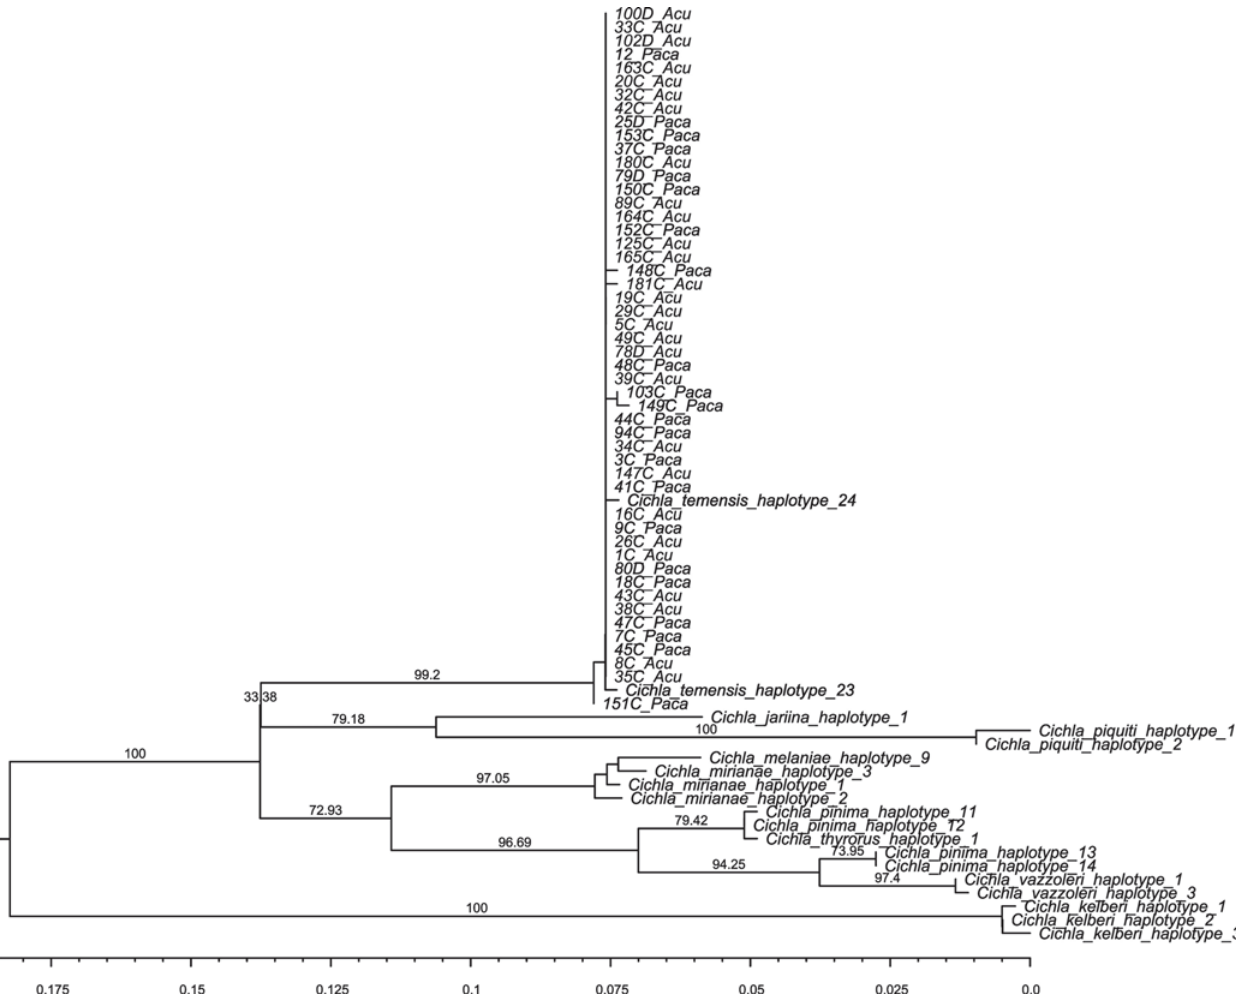
Fig. 4. Maximum-likelihood phylogeny of 50 sequences sampled from the paca and açu variants of Cichla temensis (Genbank accession numbers HQ230011 - HQ230016) The phylogeny was rooted a posteriori with Cichla species of the clade A ( sensu Willis et al. 2010) (GU295691- GU295704). The scale represents an HKY85 genetic